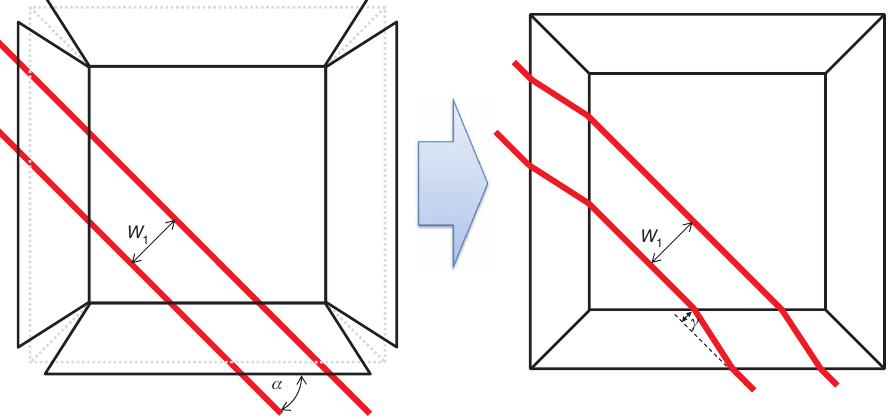
Figure 2 Projected path for geodesic paths on a ramped structure (right) with the flat projection (left).